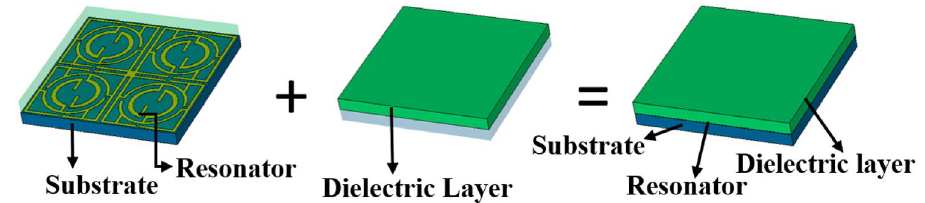
Figure 6. Proposed MTM unit cell with a dielectric layer over the resonator patch (CST microwave studio suite 2019).